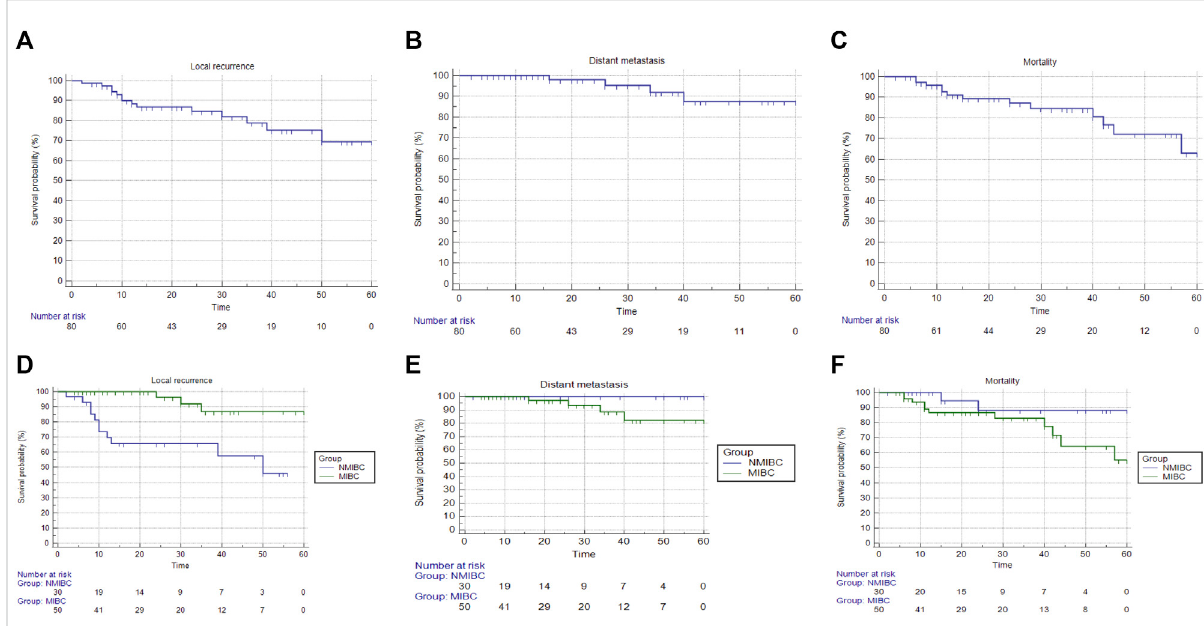
FIGURE 3 Overall survival and survival analysis of cases in both BC groups. After 5 years, patients were followed up on to see if there was a risk of local recurrence, distantmetastases,ormortality. (A)